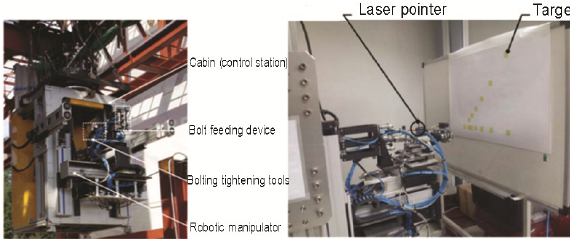
Fig. 6. The control devices in the cabin and experimental envi- ronment for the pointing task (Jung et al. 2013)